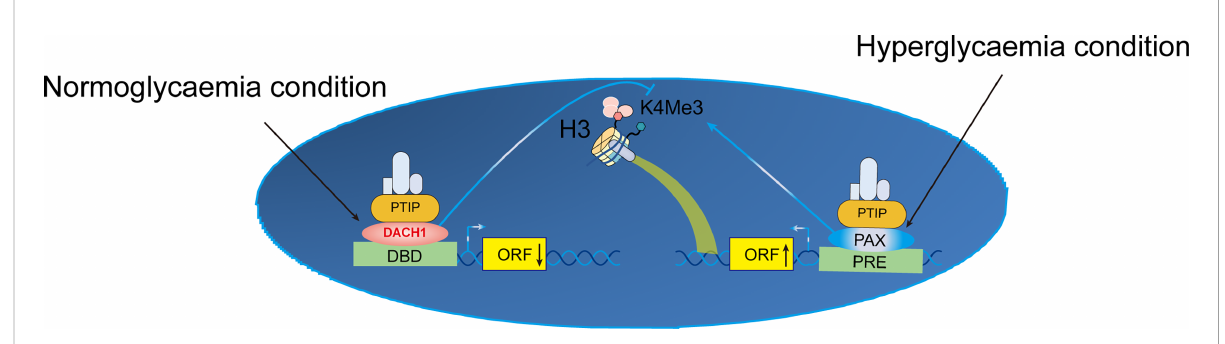
FIGURE 3 Proposed mechanism of transcriptional activation of K4Me in podocytes. Crosstalk between normal and hyperglycemic conditions in DN. ORF, open reading frame; DBD, DNA-binding domain; H3K4Me3, trimethylation of lysine 4 on histone H3 protein subunit; PRE, Pax response elements; DACH1, Dachshund homolog 1; PTIP, Pax transactivation-domain interacting